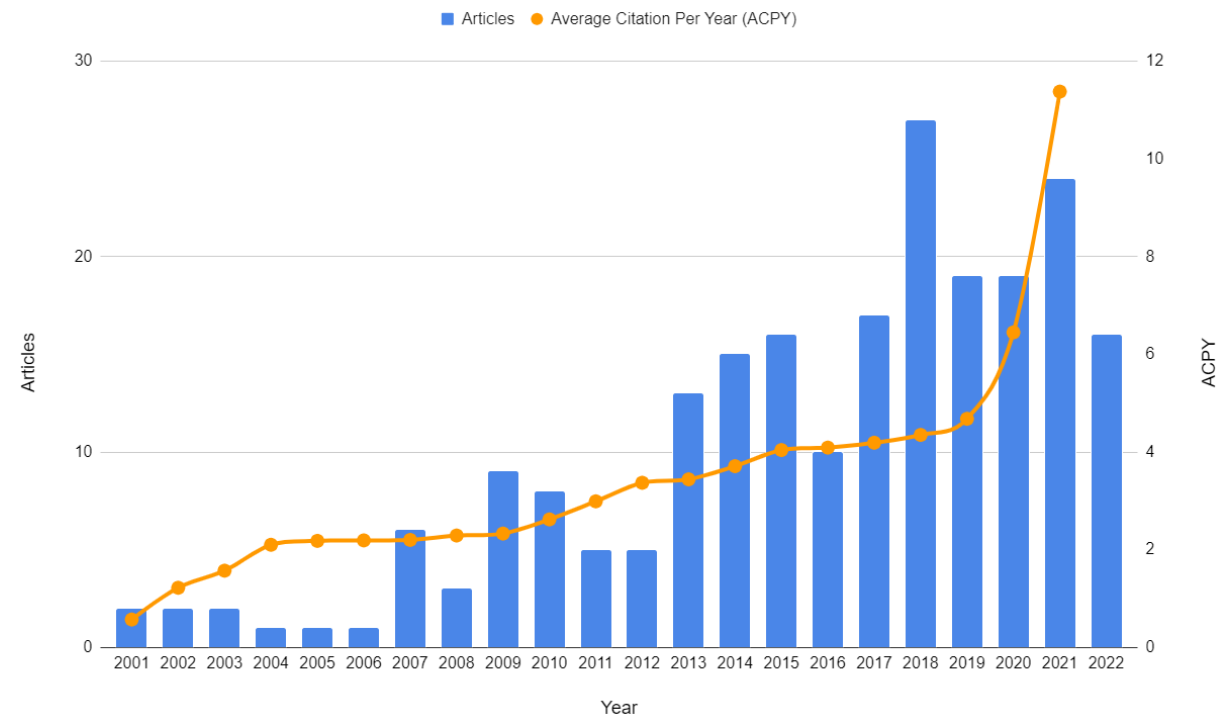
Figure 8. Publication trend in greywater recycling domain.